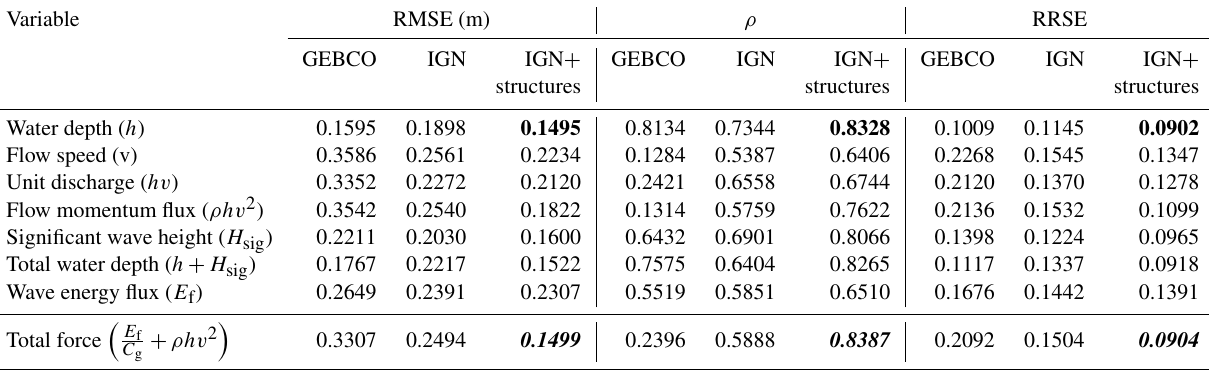
structures structures